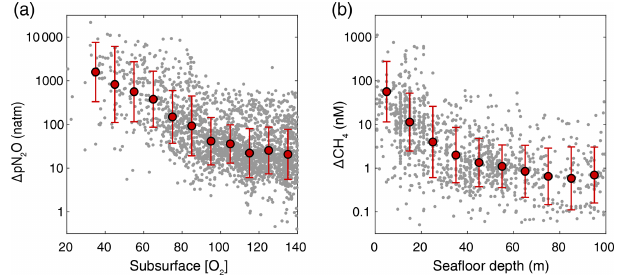
Figure 5. Key environmental predictors of surface ocean CH 4 and N 2 O gradients. (a) Excess air–sea N 2 O is best predicted by O 2 con- centrations in the subsurface water column (base of the mixed layer to a depth of 100m) (adapted from Yang et al., 2020). (b) Excess CH 4 is best predicted by seafloor depth, reflecting the supply from anoxic sediments (adapted from Weber et al., 2019). The grey dots represent individual data points and the red dots with error bars rep- resent mean ± 1SD of binned data, using O 2 bins of 10µM width and seafloor depth bins of 10m